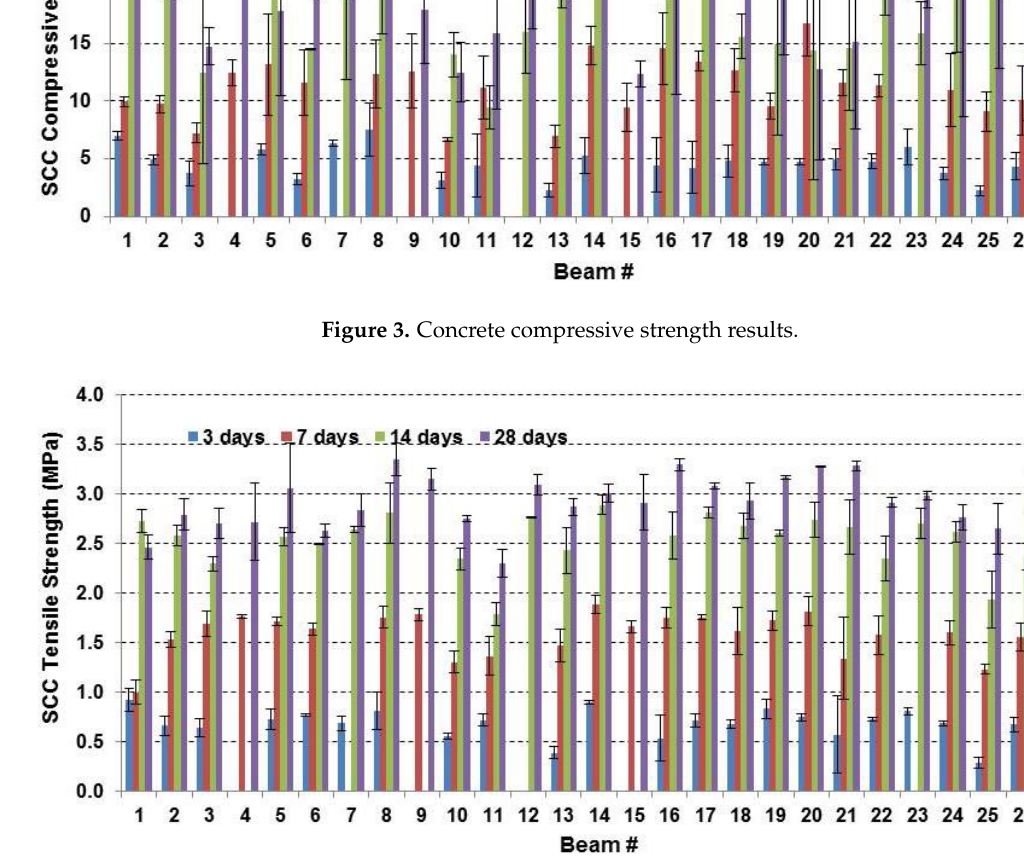
Figure 4. Concrete tensile strength results.